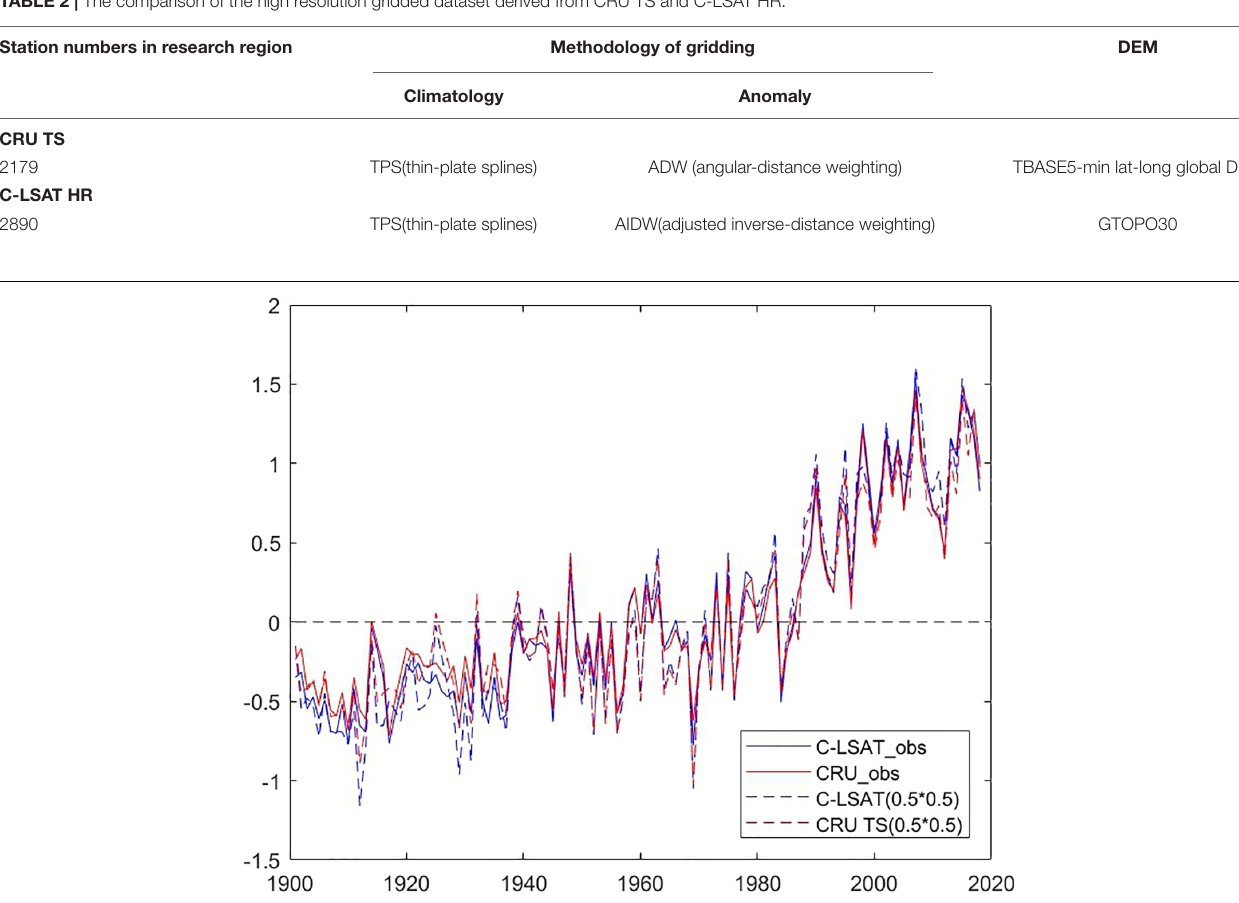
TABLE 2 | The comparison of the high resolution gridded dataset derived from CRU TS and C-LSAT HR.